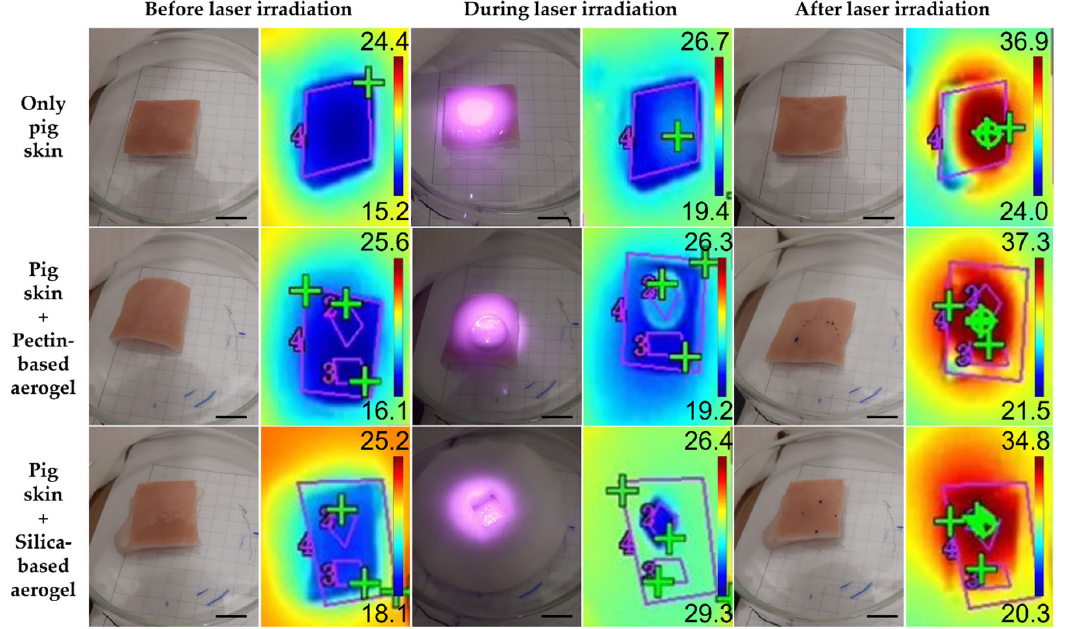
Figure 6. Real and thermal images of pig skin ex vivo grafts before, during (after 1 min of irradiation) and after laser irradiation. Scale bar: 1.3 cm.